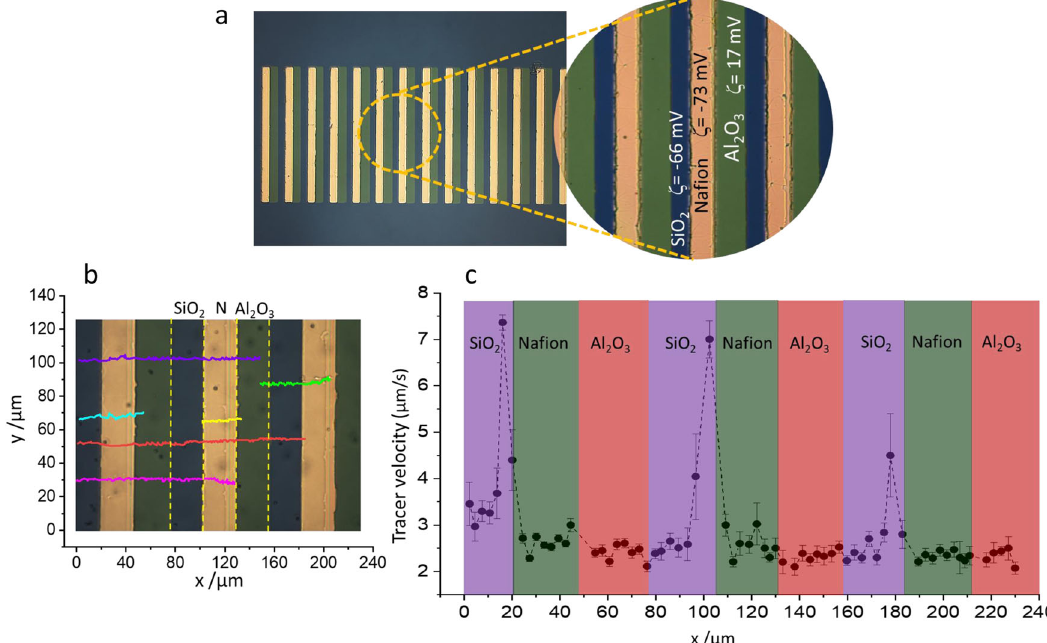
Fig. 4 Unidirectional pumping with SiO 2 /Na fi on/Al 2 O 3 nanostructures. a Patterned array of strips made from the repetitive unit composed of SiO 2 (25 μ m, ζ = − 66 ± 3 mV) /Na fi on (25 μ m, ζ = − 73 ± 3 mV) /Al 2 O 3 (30 μ m, ζ = 17 ± 2 mV). b Tracer trajectories along the patterned surface proving directional motion (N refers to Na fi on). Source data are provided as a Source Data fi le. c Average tangential velocity of tracers along the patterned structures. Polystyrene tracers in 1.0 × 10 − 4 M LiCl have been used to track the fl uid fl ow. Violet, green and red shaded areas represent SiO 2 , Na fi on, and Al 2 O 3 strips, respectively. Error bars in the fi gure represent the standard deviation. Source data of b , c are provided as a Source Data fi le.